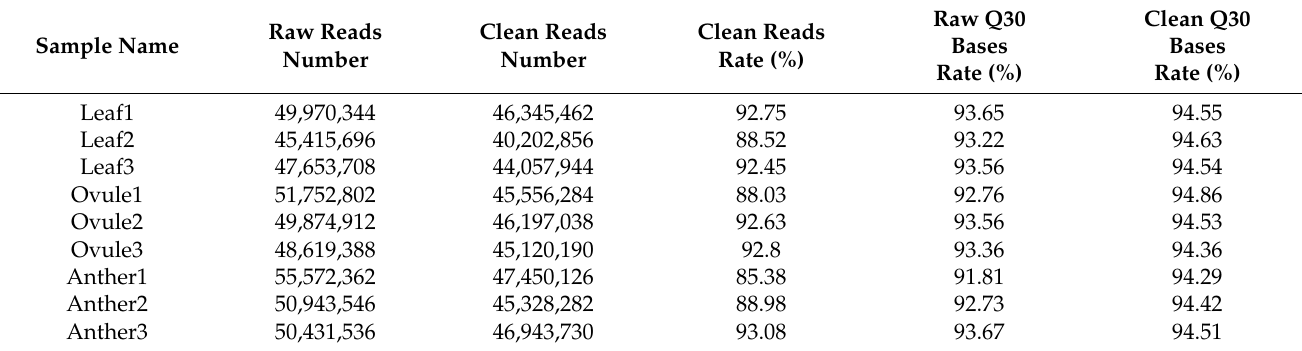
Table 1. Statistics of the RNA-Seq data in the Brassica allohexaploids.